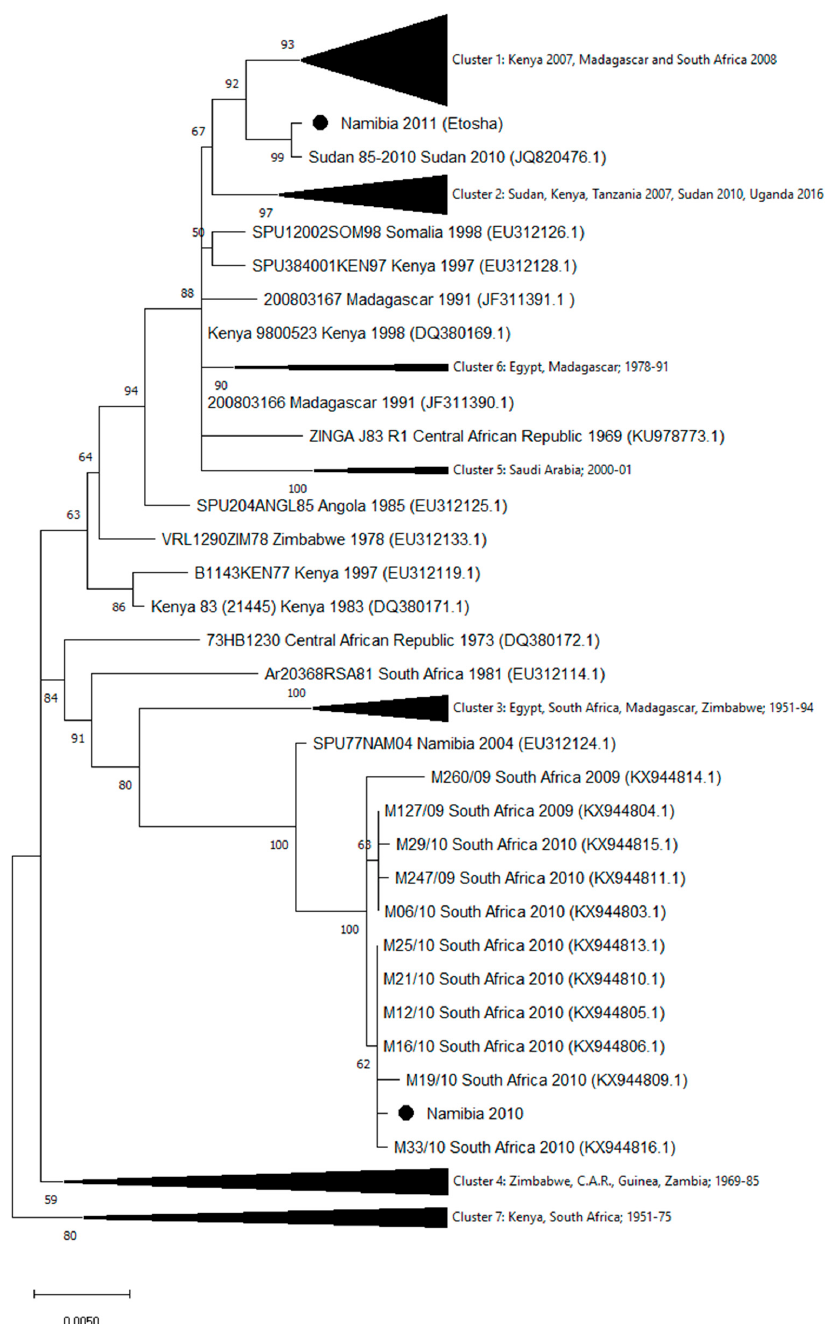
Figure 3. Phylogenetic tree of RVFV generated by the maximum likelihood method with bootstrap (500 replicates) based on 1690 nucleotides of the S genomic segment of RVFV. Analysis involved 125 sequences available in GenBank. Compressed Cluster 1 includes 41 sequences collected in Kenya in 2007 and in Madagascar and South Africa in 2008; Cluster 2: nineteen sequences collected in Sudan, Kenya, and Tanzania in 2007, in Sudan in 2010, and in Uganda in 2016; Cluster 3: thirteen sequences from Egypt, South Africa, Madagascar, and Zimbabwe, collected from 1951 to 1994; Cluster 4: eleven sequences from Zimbabwe, C.A.R., Guinea, and Zambia, collected between 1969 and 1985; Cluster 5: three sequences from Saudi Arabia (2000–2001); Cluster 6: three sequences from Egypt and Madagascar (1978–1991); Cluster 7: nine sequences from Kenya and South Africa, collected between 1951 and 1975. Strain names and accession numbers of the sequences included in the compressed clusters are listed in Table